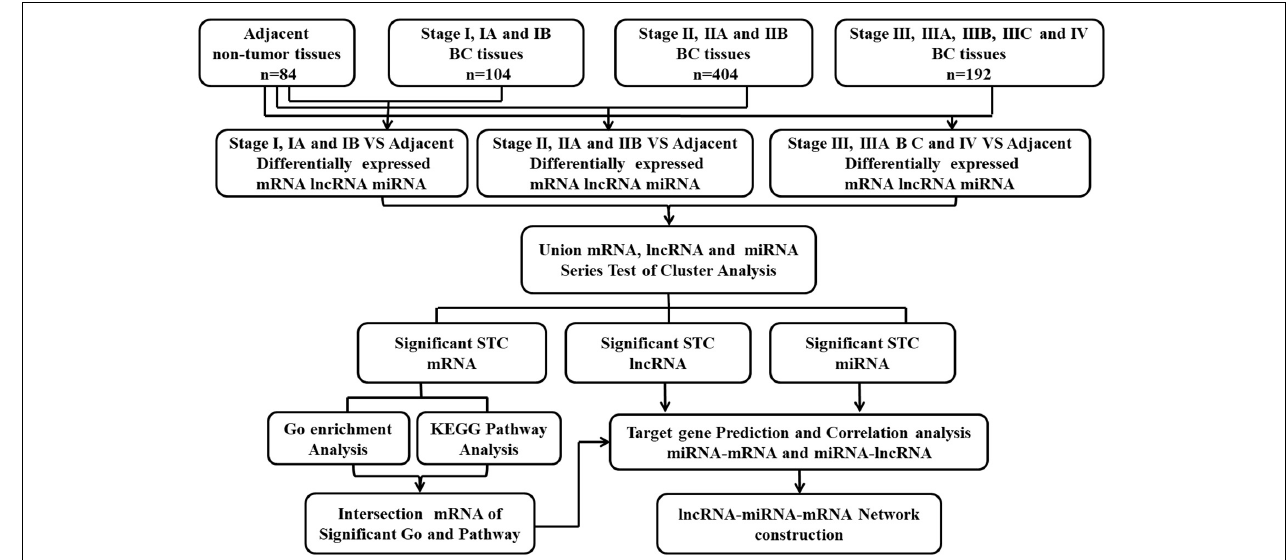
FIGURE 1 | Flow-chart of data